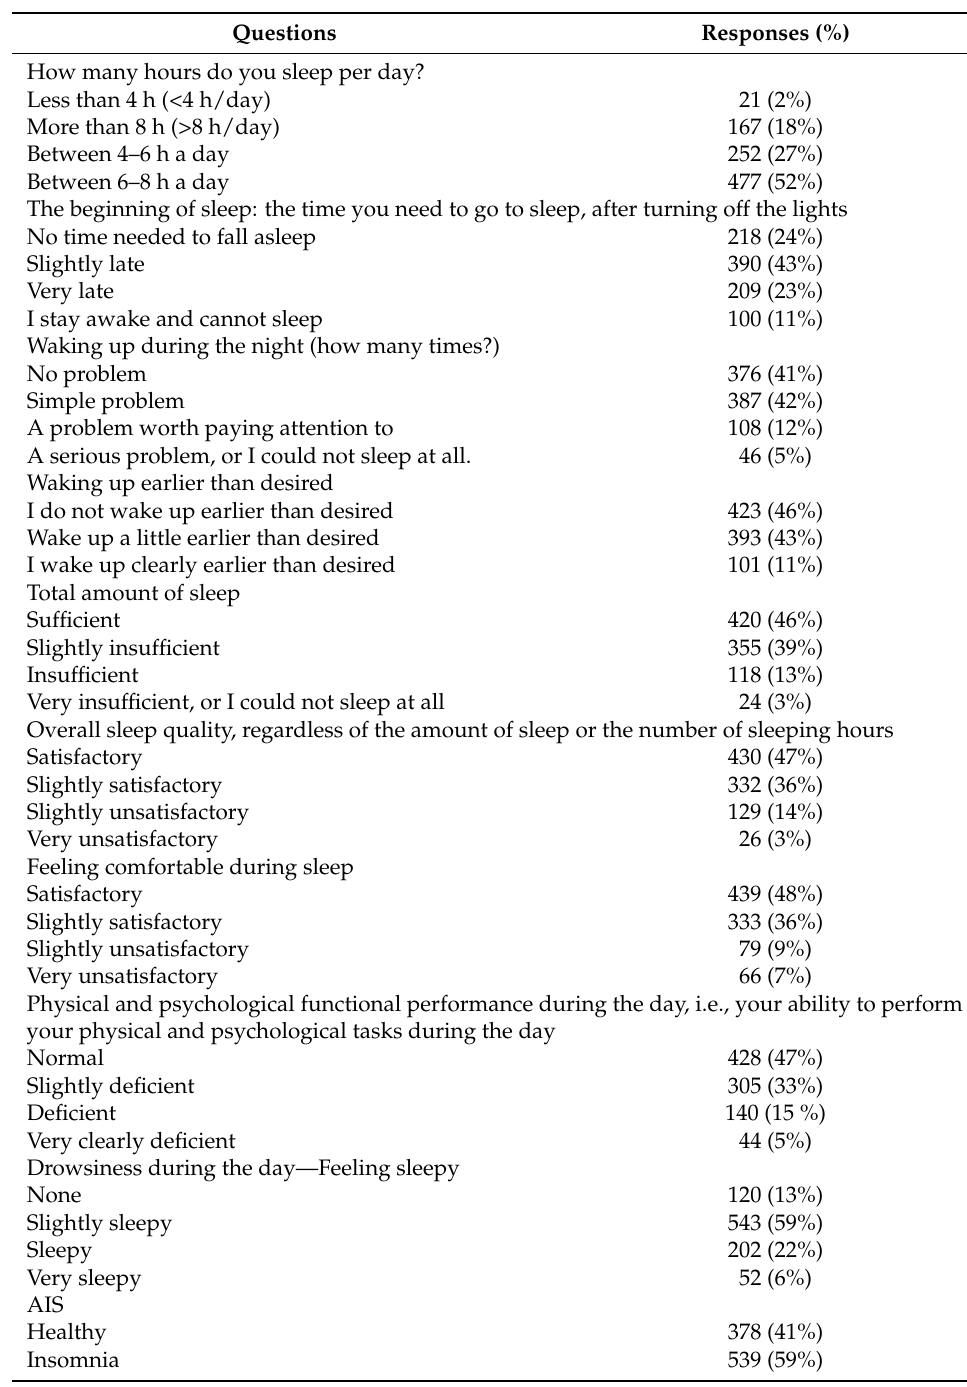
Table 3. Sleep difficulty assessment in the 917 female